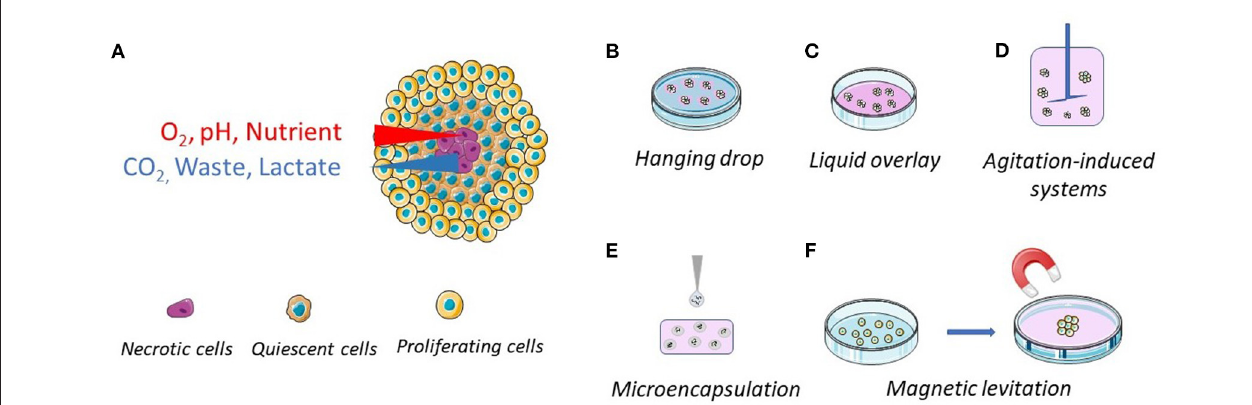
FIGURE 1 | Schematic representations of the general structure of a multicellular tumor spheroid and of their common preparation methods. (A) The spheroid structure, with proliferating (outside layer), quiescent (intermediate layer) and necrotic (center) cells. The cellular density is lower in the outside layer. (B) Hanging drop method, where the cells come together at the bottom of a hanging drop. (C) Liquid overlay method, where the surface of plates or wells is coated with a non-adhesive material. (D) Spinner flasks (stirred or rotating vessel), where the cells are kept in suspension. (E) Microencapsulation and (F) magnetic levitation, where the cells, engulfed with magnetic particles, are brought together through magnetic